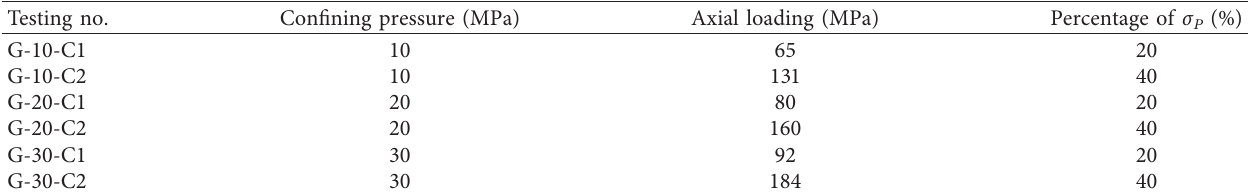
Figure 5: The schematic diagram of loading process: (a) the path of cyclic loading tests; (b) the path of ascending step cyclic loading tests. Table 3: Testing data of preliminary cyclic loading tests.